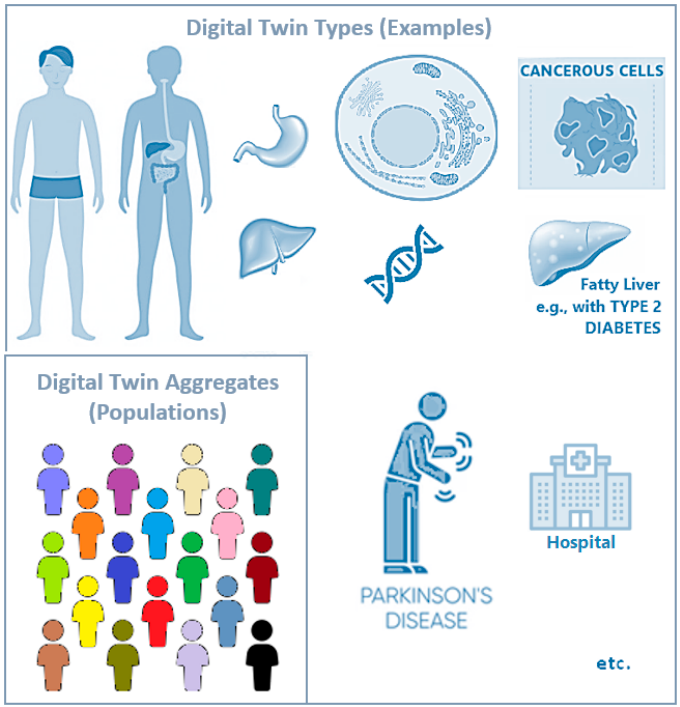
Figure 2. Key concepts and examples of human digital twins: digital twin types and aggregates. From left to right: Different types of digital twins can be conceived, covering the whole human body, one body system or body function (e.g., digestive system), one body organ (e.g., stomach or liver), one cell of a given type, or even simply some specific subcellular (organelle/sub-organelle) or molecular level of interest within a cell. Digital twins can equally cover healthy/normal and diseased entities; for example, a diseased cell (e.g., a cancerous cell of some given type), a diseased organ (e.g., a fatty liver in type 2 diabetes), or a disease or syndrome affecting the whole body or multiple parts of it (e.g., Parkinson’s disease). Healthcare institutions (e.g., a hospital) can also have their corresponding ‘digital twins of organisations’. Left inset: Aggregates of the corresponding digital twins belonging to different individuals can be used to represent one family, population group, or whole